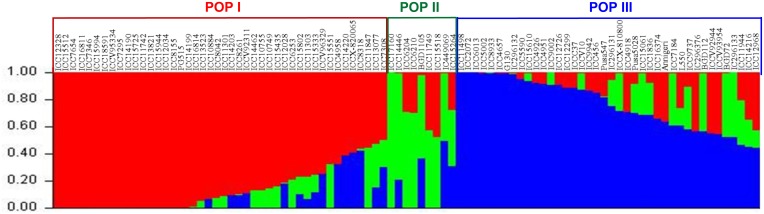
Population structure with population number K = 3 and their inferred best possible population genetic structure for 93 chickpea accessions using 23,798 high-quality GBS-based SNPs (MAF ≥ 0.05). These mapped markers assigned accessions into three populations (POP I, POP II, and POP III) that primarily corresponded to their cultivar/species-specific origination. The accessions represented by vertical bars along the horizontal axis were classified into K color segments based on their estimated membership fraction in each K cluster. Three diverse colors represent different populations based on the optimal population number K = 3.